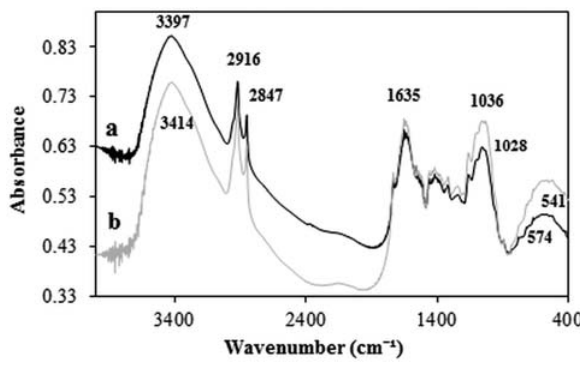
Figure 8. FTIR spectra of WGT treated with NaOH before adsorp- tion (a) and after MG adsorption